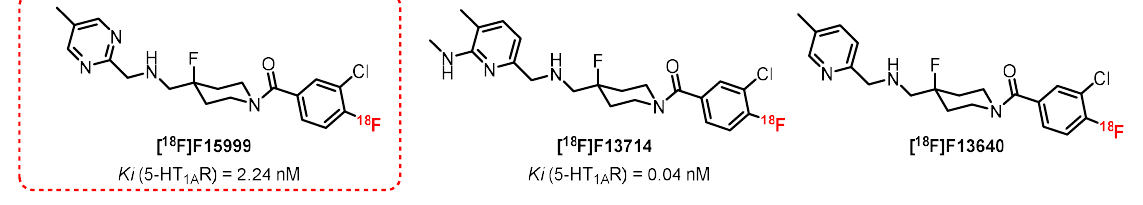
Figure 3. F15999 derivatives.